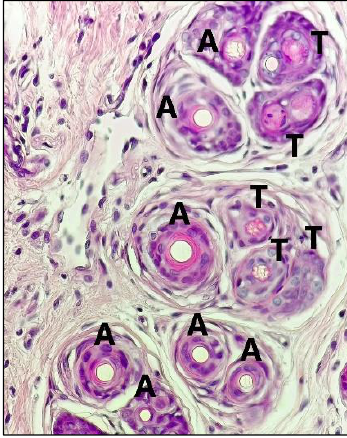
Figure 4. Photomicrograph profile of anagen (A) and telogen (T) (magnification 40 × ).